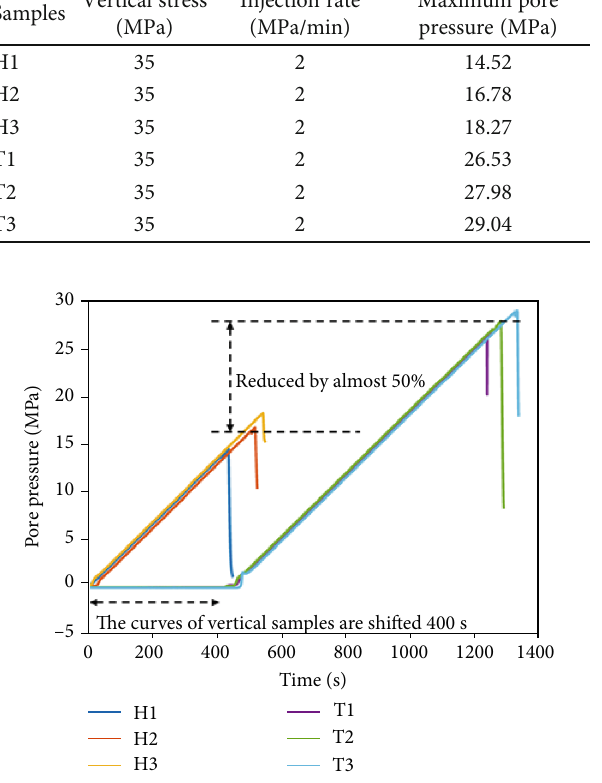
Figure 3: Time history of the pore